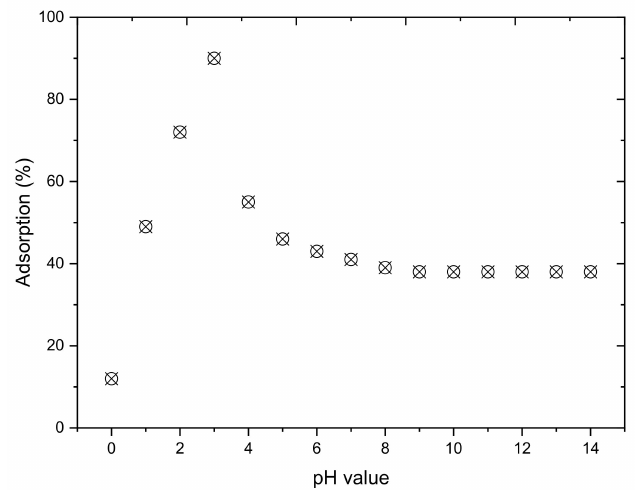
Figure 3. Cr(VI) adsorption percentage as a function of the solution pH. Aqueous phase: 0.01 g / L Cr(VI) at di ff erent pH values. Carbon dosage: 0.5 g / L. Temperature: 20 ◦ C. Time: 5 h. Stirring speed: 1000 min − 1